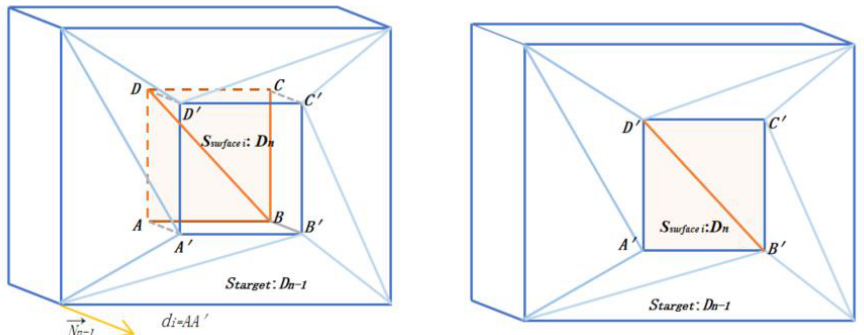
Figure 9. Model transformation based on continuous LOD topological data structure.